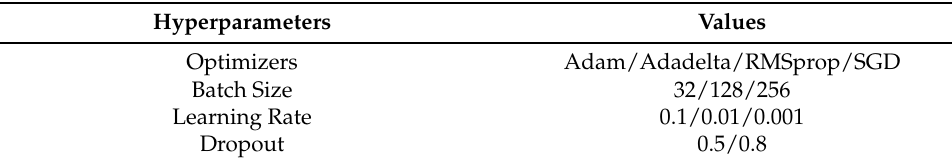
Table 1. The combinations of